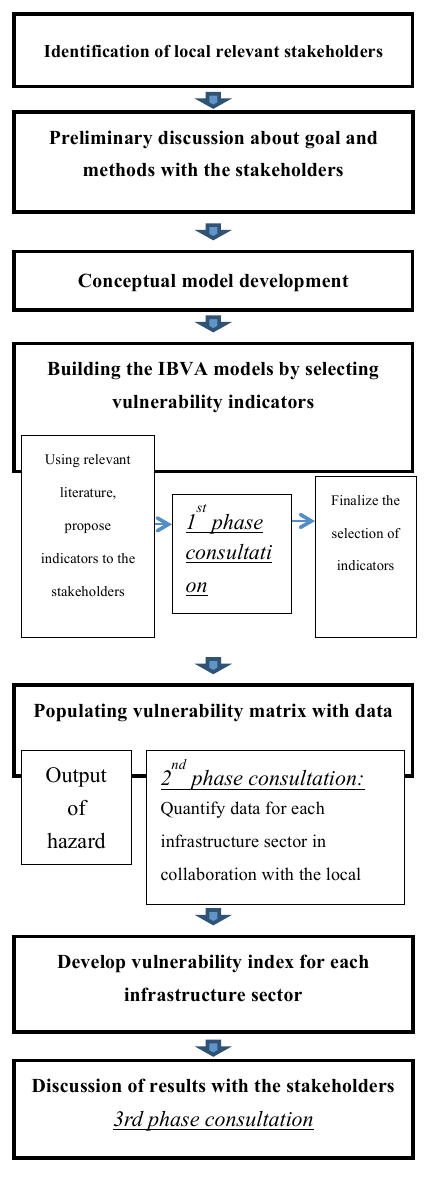
Figure 1. Stakeholder consultation and information flow process.